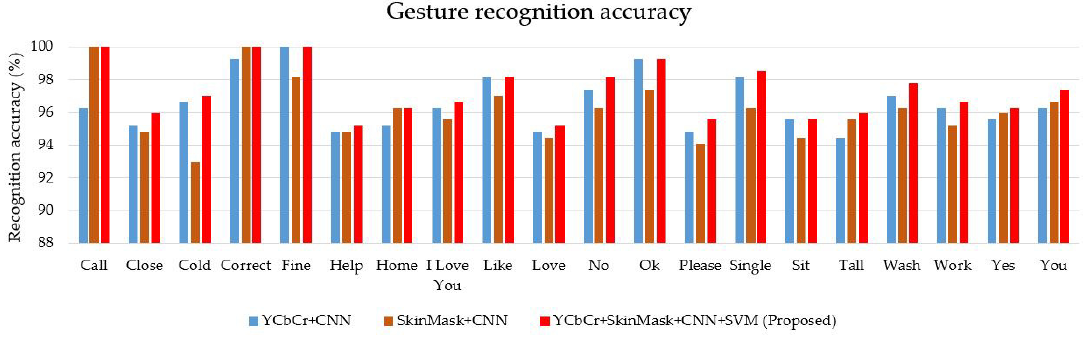
Figure 15. Comparison of average recognition of hand gestures.